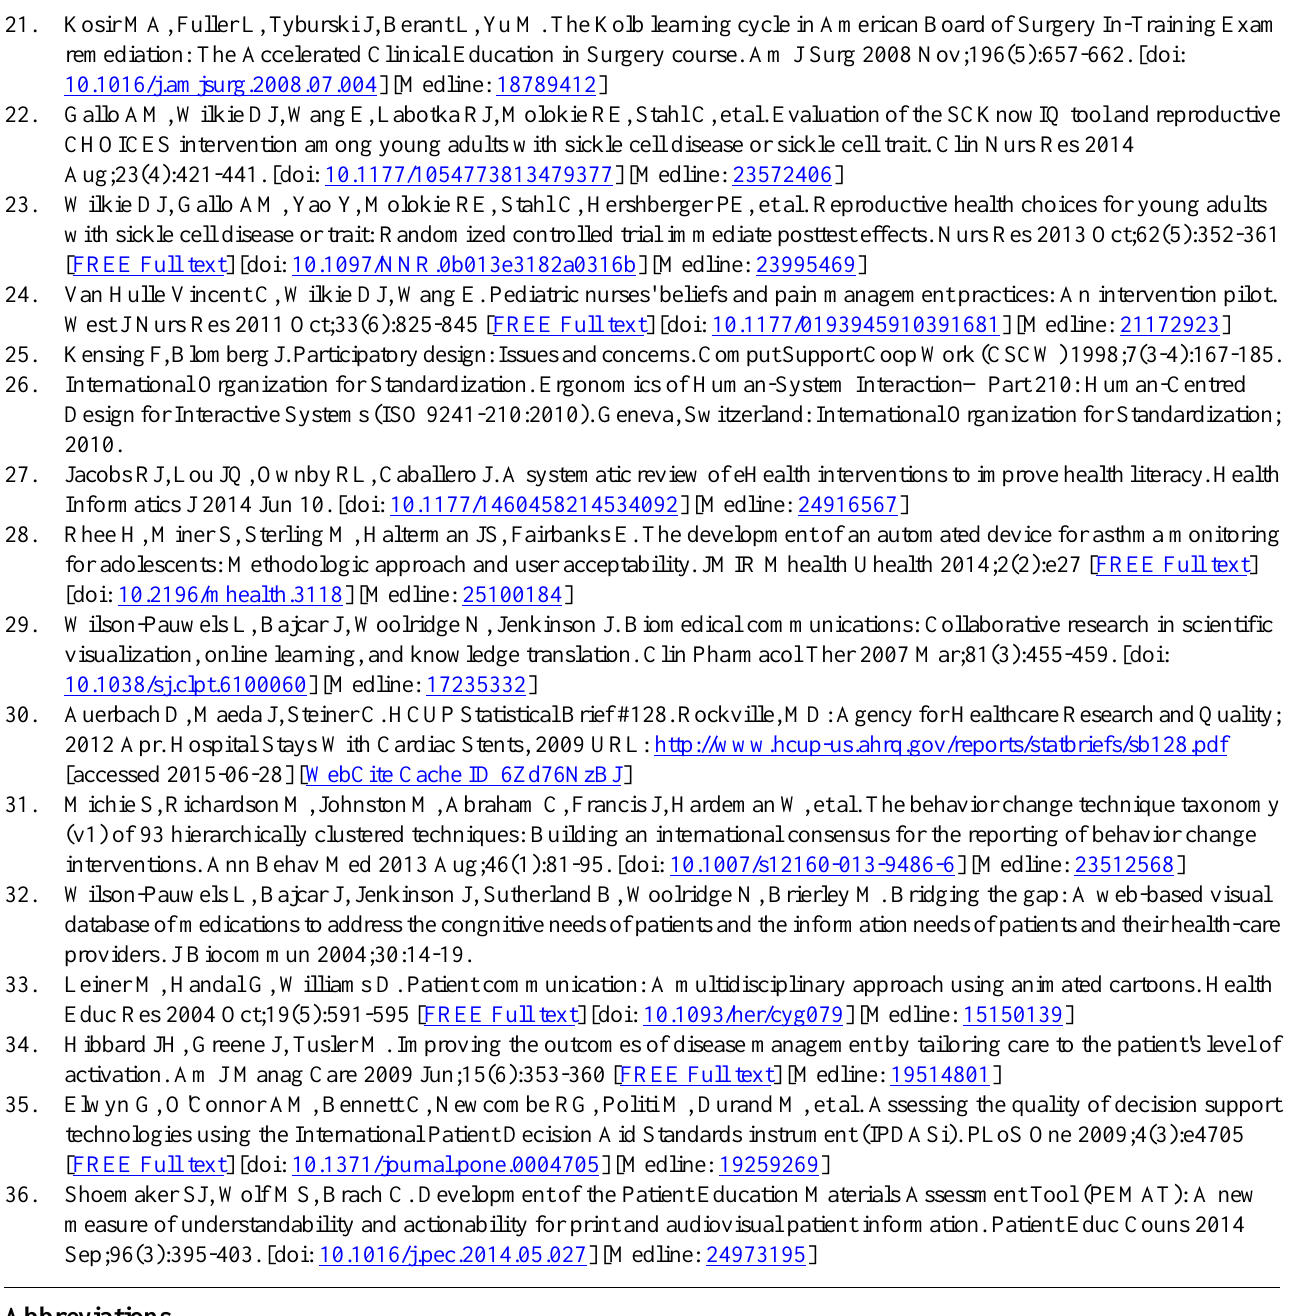
Abbreviations BCT: behavioral change technique DAPT: dual antiplatelet therapy DES: drug-eluting stent IRB: Institutional Review Board ISO: International Standardization Organization MyIDEA: My Interventional Drug-Eluting Stent Educational App PCI: percutaneous coronary